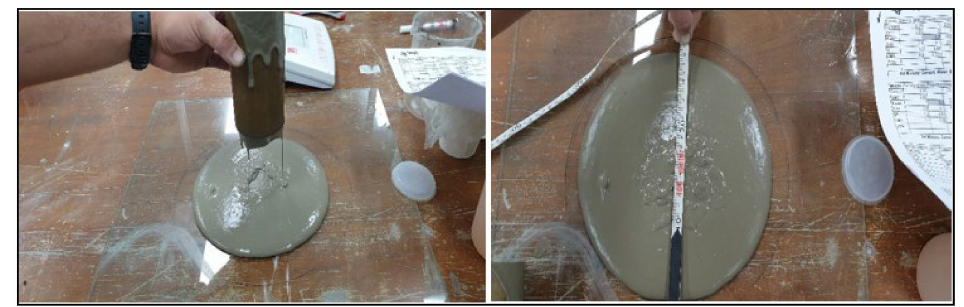
Figure 7. Mini slump spread measurement. For the initial setting time, the Vicat apparatus (HD-102, Hyundai, Seoul, Korea) was used (as shown in Figure 8). The grout was tested after 1 h to obtain the results.